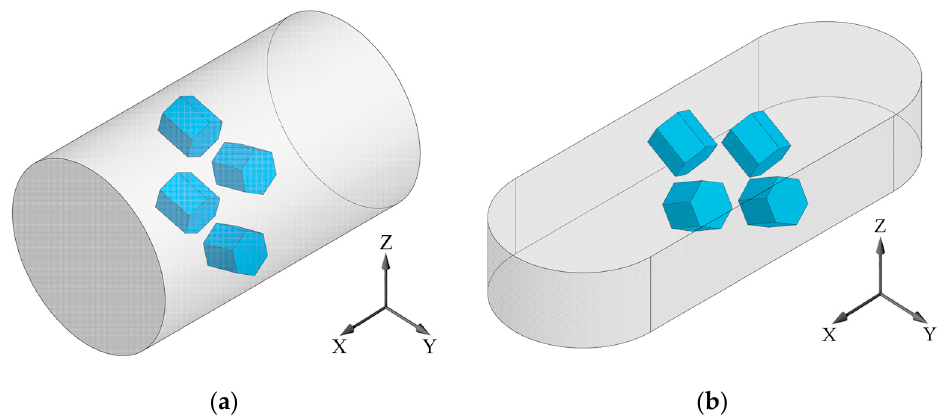
Figure 6. Schematic view showing the position of the crystallites of the hcp α -phase in the UFG structure of the Ti-6Al-4V titanium alloy after: ( a ) ECAP; ( b ) ECAP + upsetting.